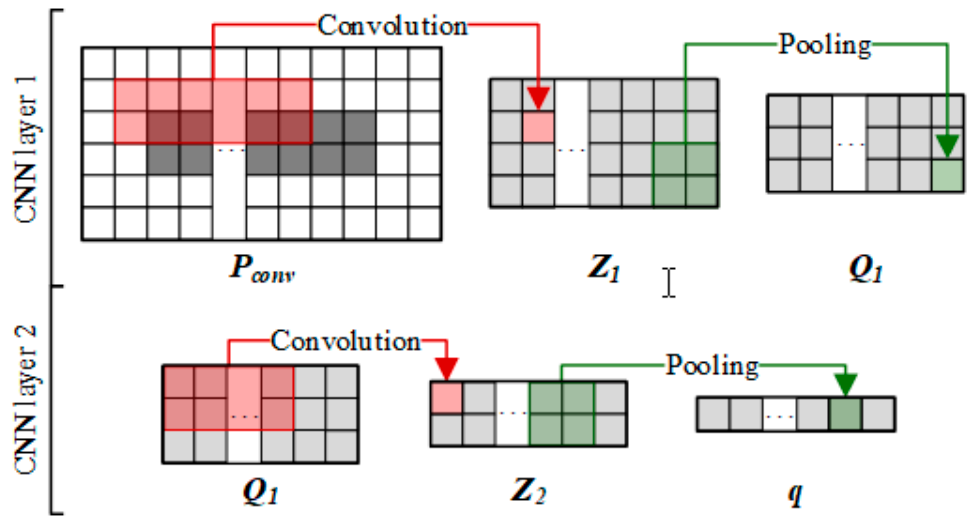
Figure 4. Learning process of the original representation of drug–disease pair by convolution and pooling on the left part.